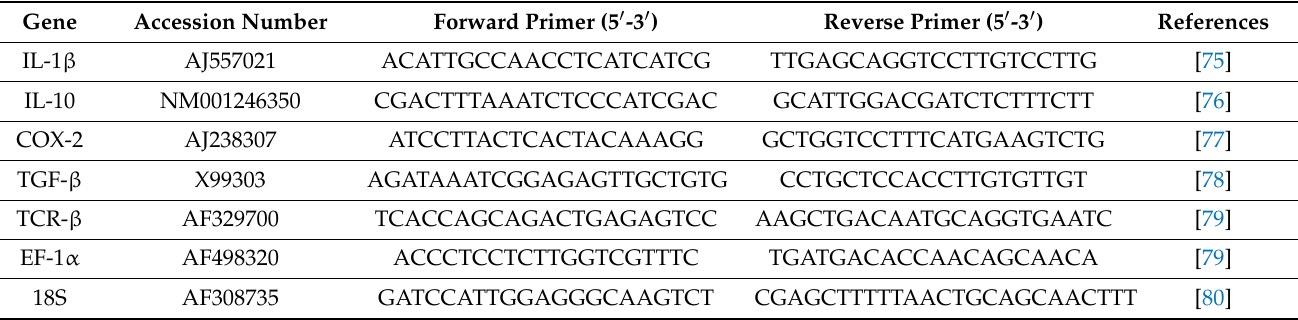
Table 4. Primers used to evaluate gene expression by